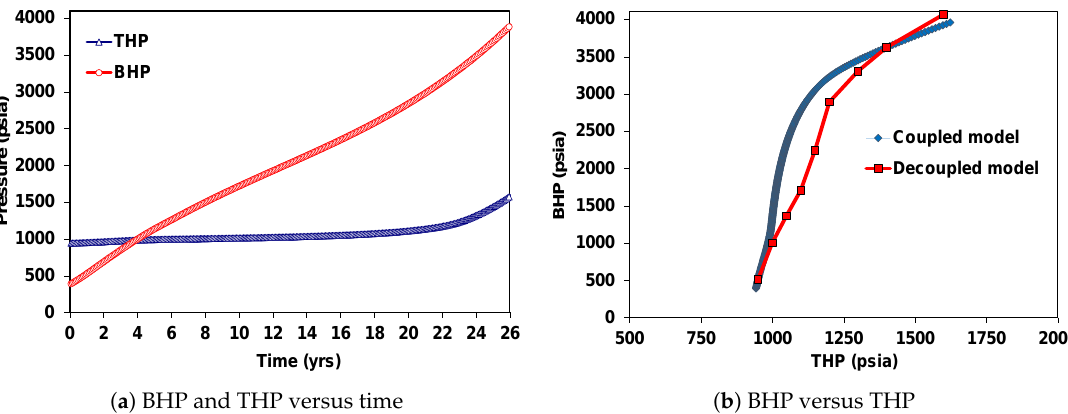
Figure 11. BHP and THP versus time from the coupled model ( a ) and comparison of the BHP–THP curves from the coupled and decoupled models ( b